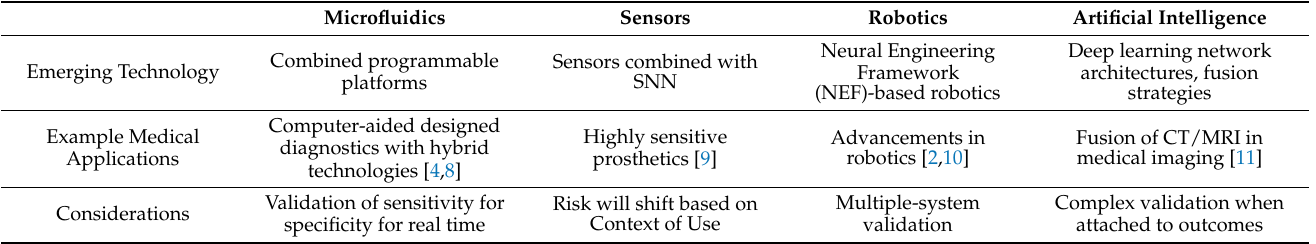
Table 1. Examples of implementing brain-inspired architecture with emerging technologies—considerations for verification and validation when translating to